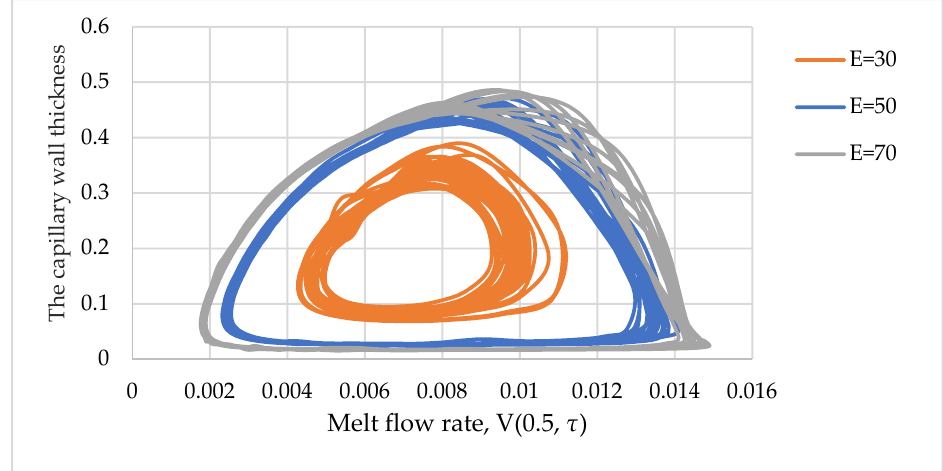
Figure 12. Dynamic system attractor.